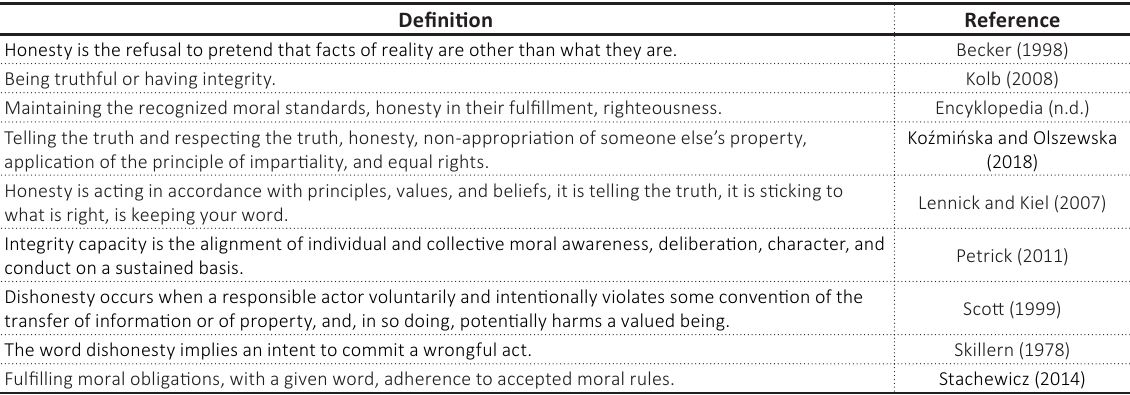
Table 1. Overview of selected